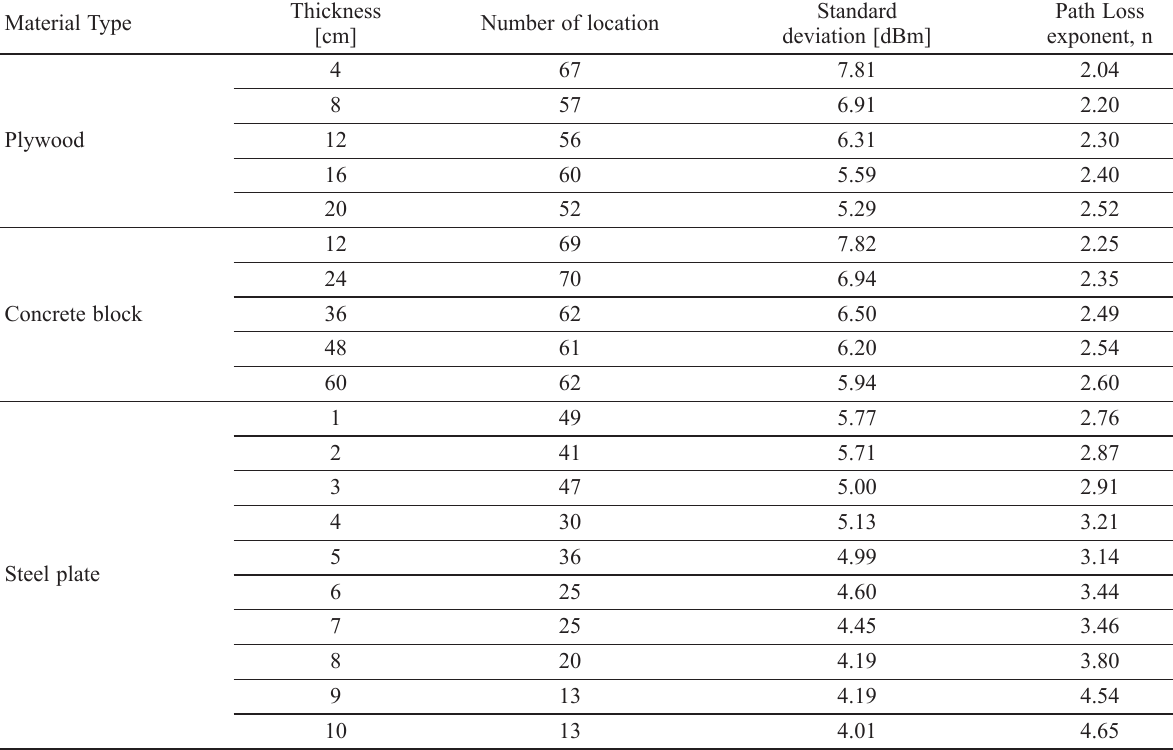
Table 1. Path loss exponent and standard deviation according to the materials and thickness Material